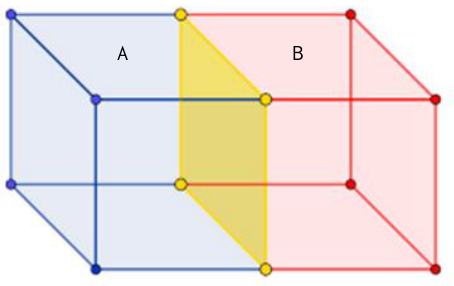
Figure 4 . 3D to 3D “meet (touches)” topological relationship.